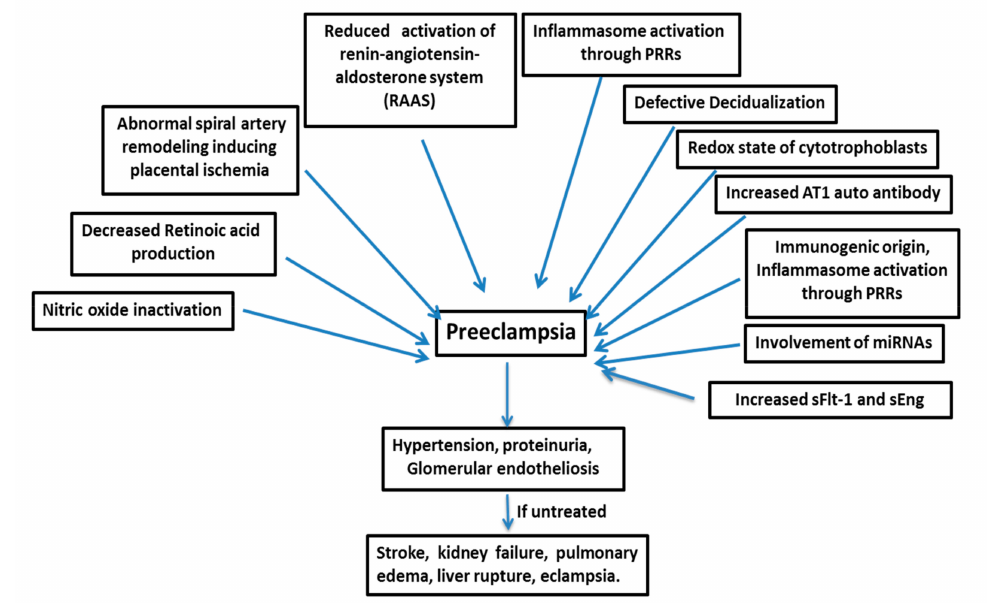
Figure 1. Preeclampsia is a multifactorial disease. sFlt-1 = soluble fms-like tyrosine kinase-1, and sEng = soluble